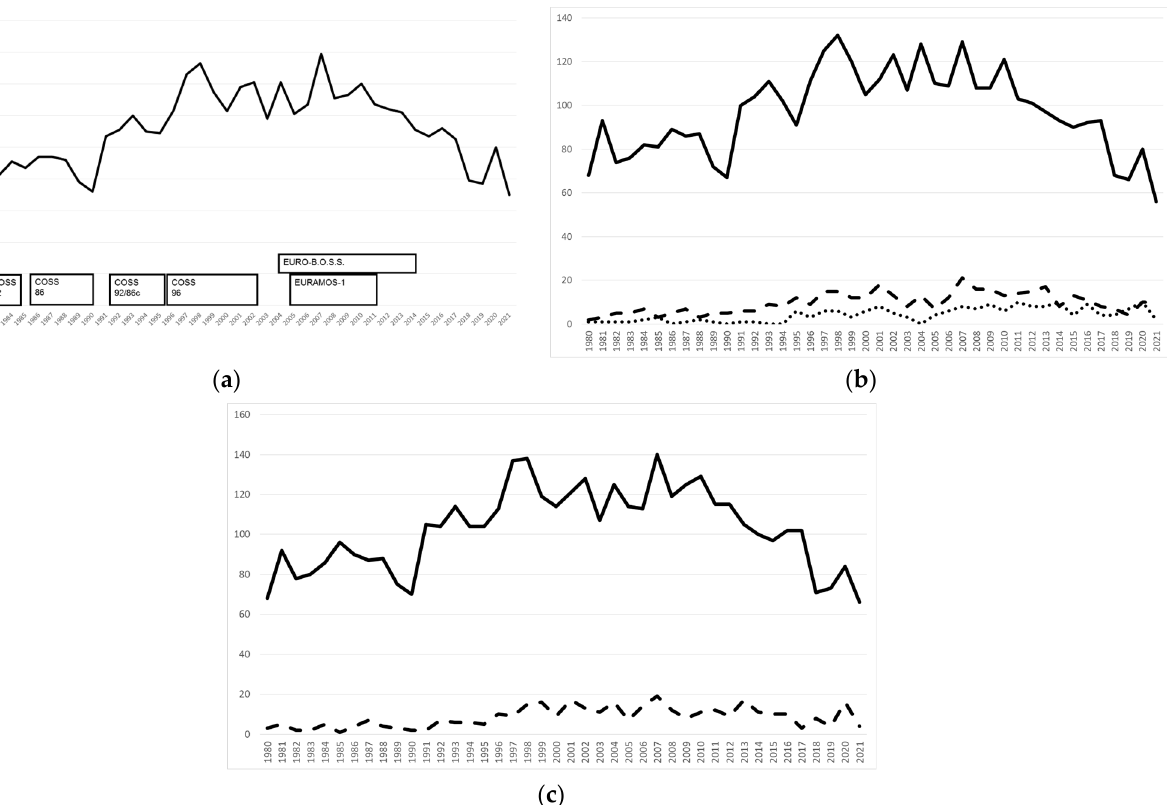
Figure 1. Recruitment per year of 4657 previously untreated Cooperative Osteosarcoma Study Group osteosarcomas 1980–2001. Patients registered > 1 year after biopsy excluded. ( a )—all 4657 patients. ( b )—by primary tumor site: limb ( n = 4071, solid line) vs. trunk ( n = 404, dashed line) vs. head and neck ( n = 177, dotted line); 5 primary sites unknown. ( c )—by grade of malignancy: high-grade central ( n = 4136, solid line) vs. others ( n = 337, dashed line); head and neck osteosarcomas excluded; 8 grades not documented.